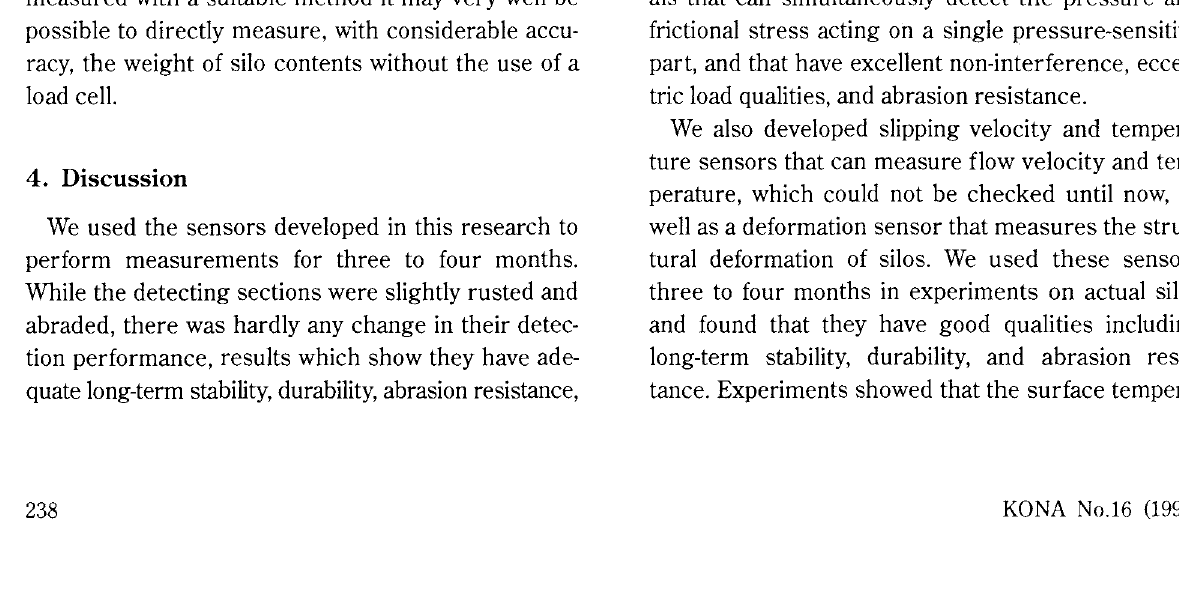
the silo skirt. Before making measurements we placed two horizontal bars in a plus shape on the silo's top in the N-S and E-W directions so that an eccentric load would be imposed. First we measured the output of all deformation sensors with equal loads in all four directions (Fig. 24(a)), and found that W and S deformation was greater than E and N deforma